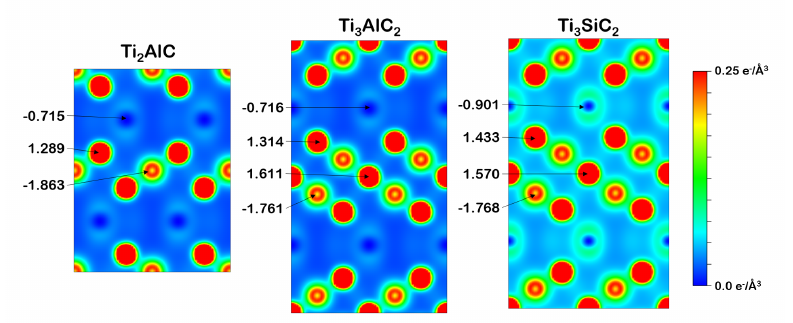
Figure 2. Charge density colour map through a (110) slice of the bulk unit cell with the Bader charge of each